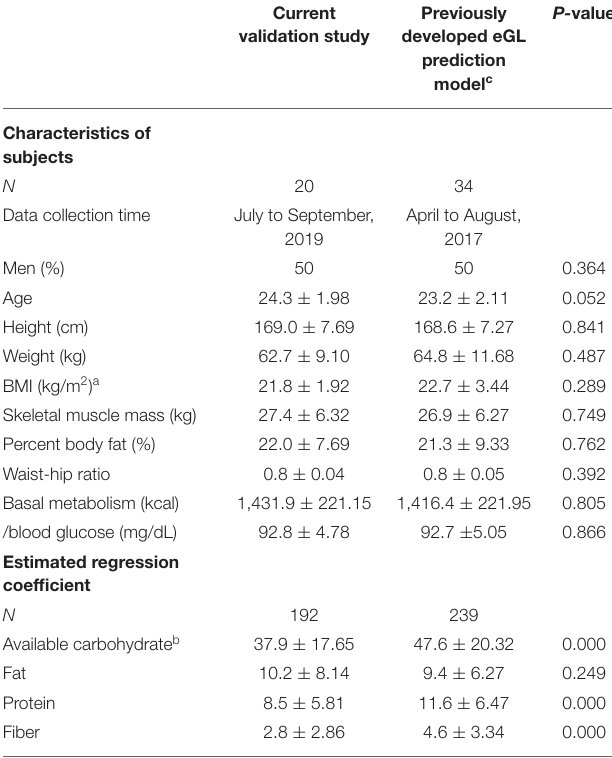
TABLE 1 | Comparison of characteristics between validation subjects and development subjects for eGL prediction